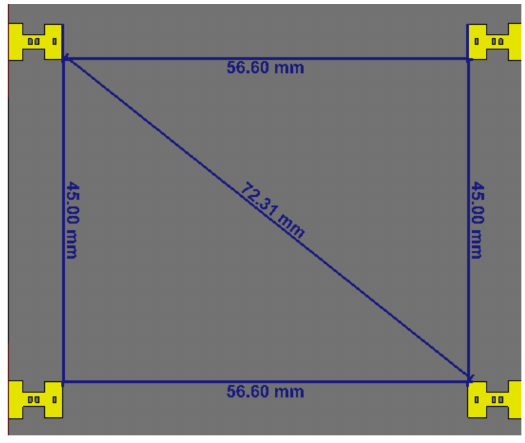
Figure 7. A 4-port mmWave MIMO configuration.